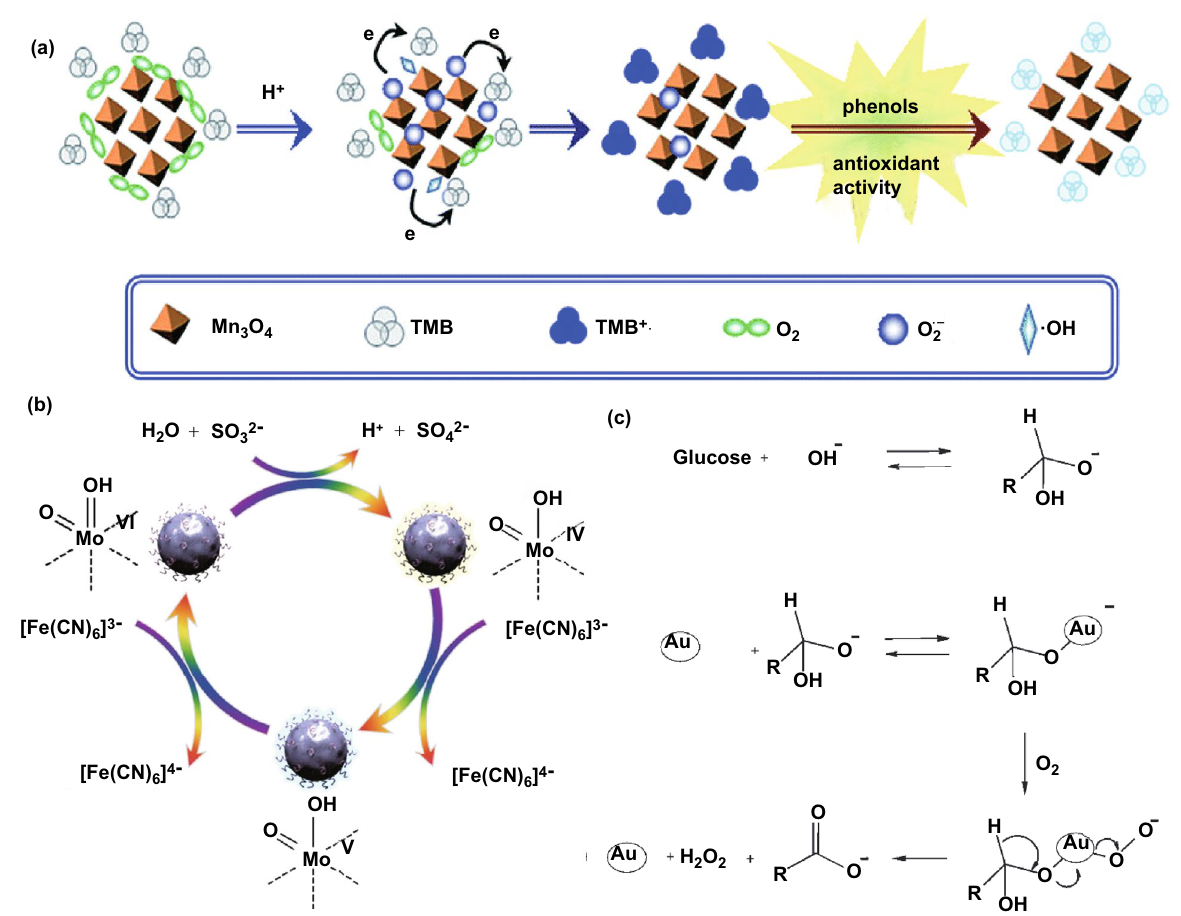
Fig. 4 a Reaction of the TMB oxidized by Mn 3 O 4 NPs with OXD-like activity. b Possible reaction mechanism for the SuOx-type activity of P ‐ MoO 3 −x NPs in the presence of sulfite and K 3 [Fe (CN) 6 ]. c Catalytic mechanism of Au NPs as GOx mimics. Adapted from a Ref. [196], b Ref. [198], c Ref. [199] with